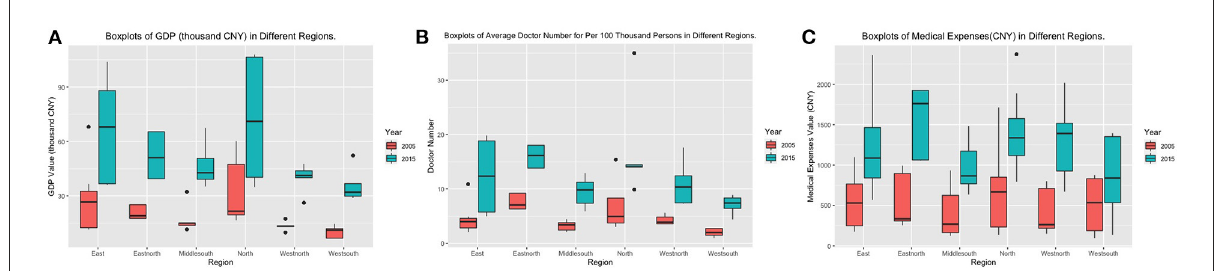
FIGURE3 Boxplots for medical care and economic status within different regions. (A) Boxplot of GDP within different regions in China. (B) Boxplot of the average number of doctors for per 100,000 persons within different regions in China. (C) Boxplot for medical expenses within different regions in